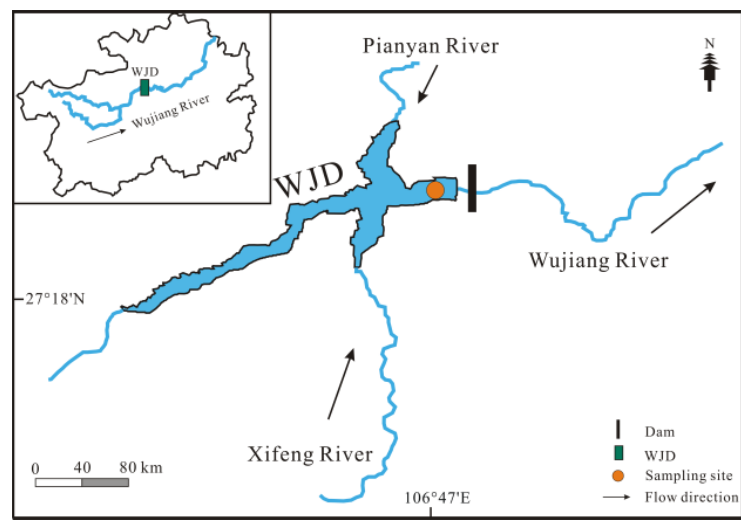
Figure 1. Map showing the study area and the sampling sites at the WJD reservoir.